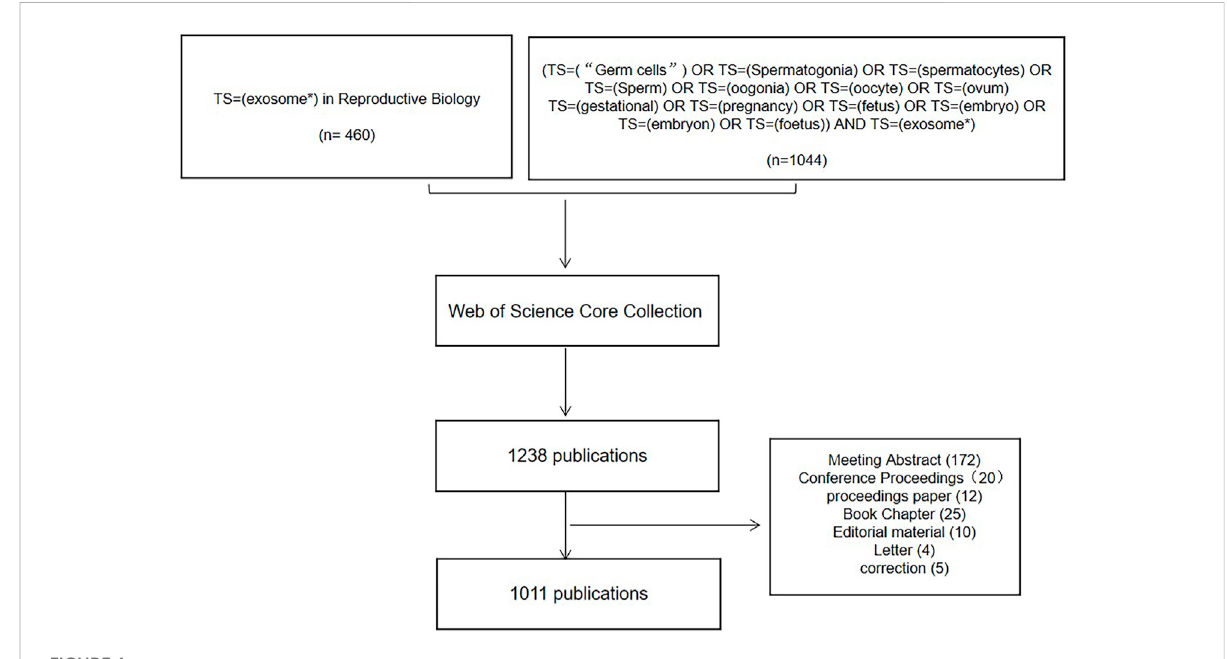
FIGURE 1 Flowchart of search strategy and included